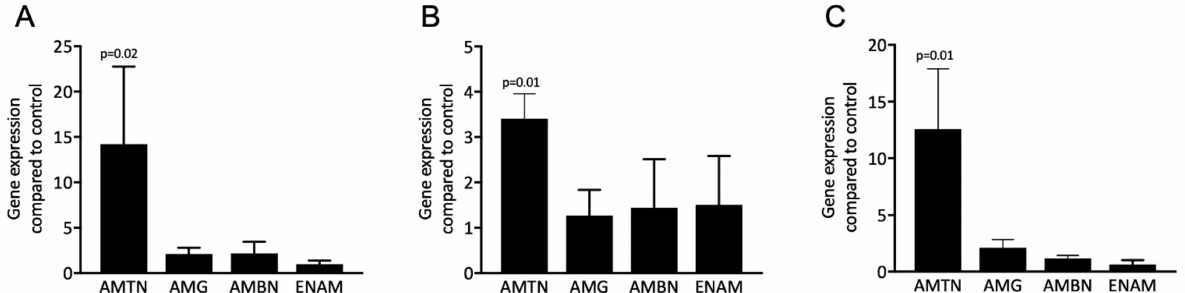
Figure 1. ADL modulates expression of AMTN but not AMG, AMBN, or ENAM. RT-PCR of AMTN, AMG, AMBN, and ENAM in ( A ) human oral squamous (HSC2), ( B ) buccal carcinoma (TR146), and ( C ) gingival fibroblast (GF) cell lines revealed significant changes in the expression of AMTN, but not EMPs using ADL. N = 3. Statistics based on one-way ANOVA Kruskal–Wallis test. Values are the means ± SD of the treated samples versus untreated